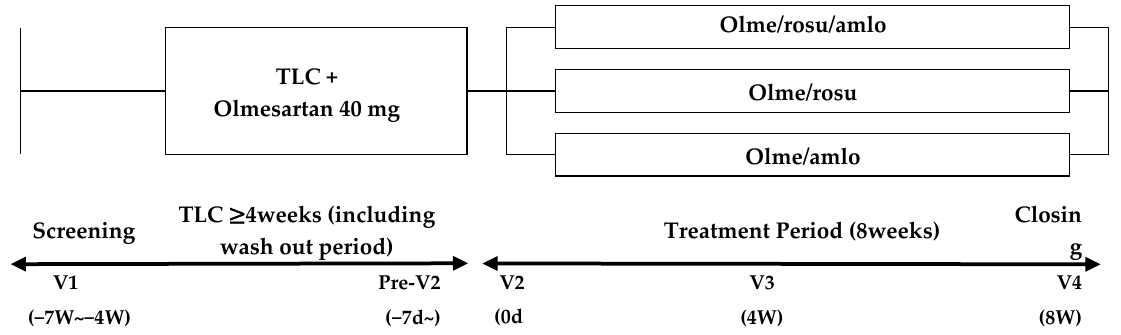
Figure 1. Study scheme. TLC, therapeutic life style change; olme, olmesartan; rosu, rosuvastatin; amlo, amlodipine; v, visit.